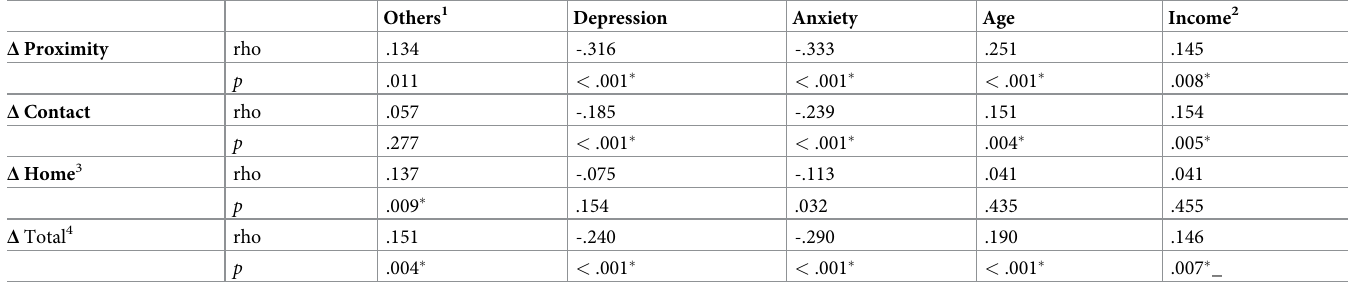
Table 6. Correlations of five independent variables with adaptive changes in mitigation